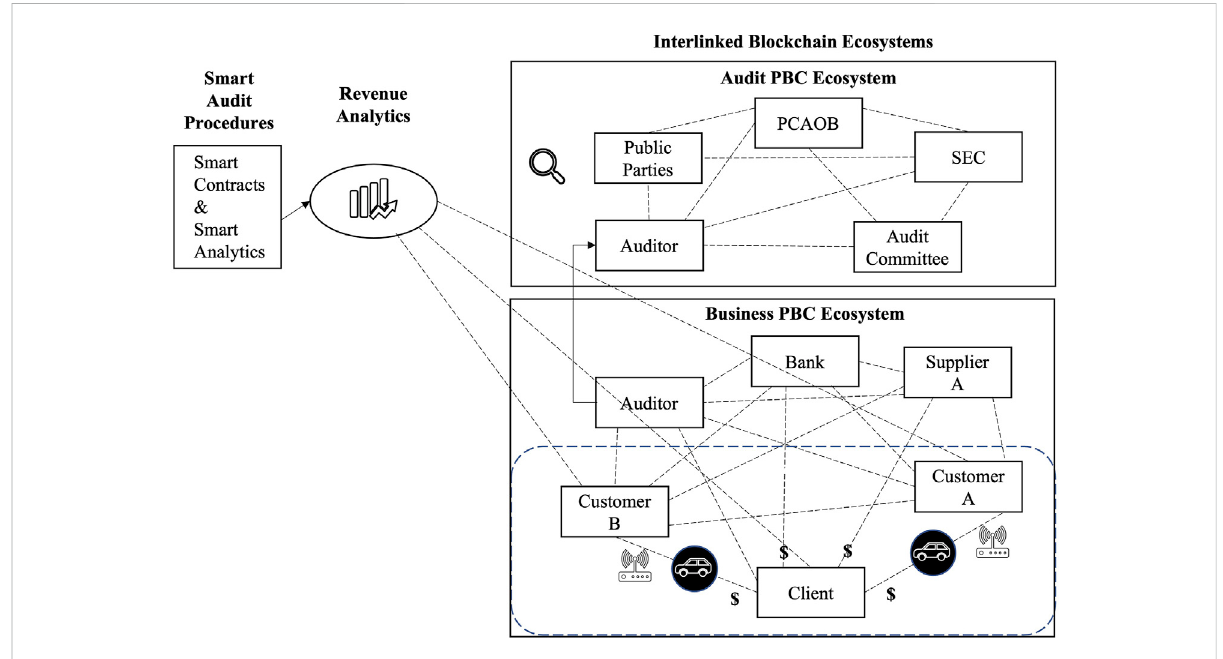
FIGURE 6 Interlinked blockchain ecosystems (Sheldon,